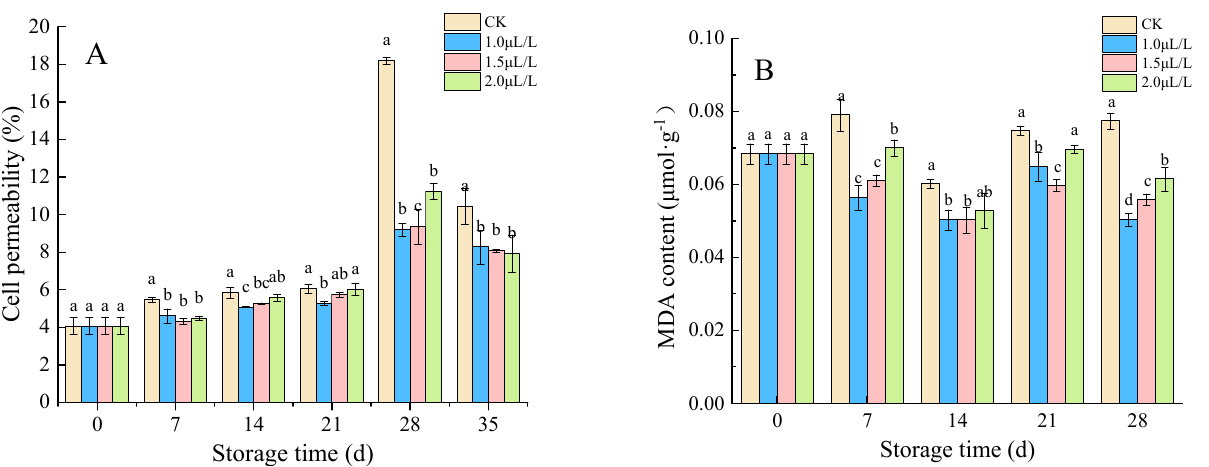
Figure 3. Effects of 1-MCP on cell permeability ( A ) and MDA content ( B ) in root mustard. Different letters at each time point indicated a significant difference between treatments ( p < 0.05) by Duncan’s multiple range test.